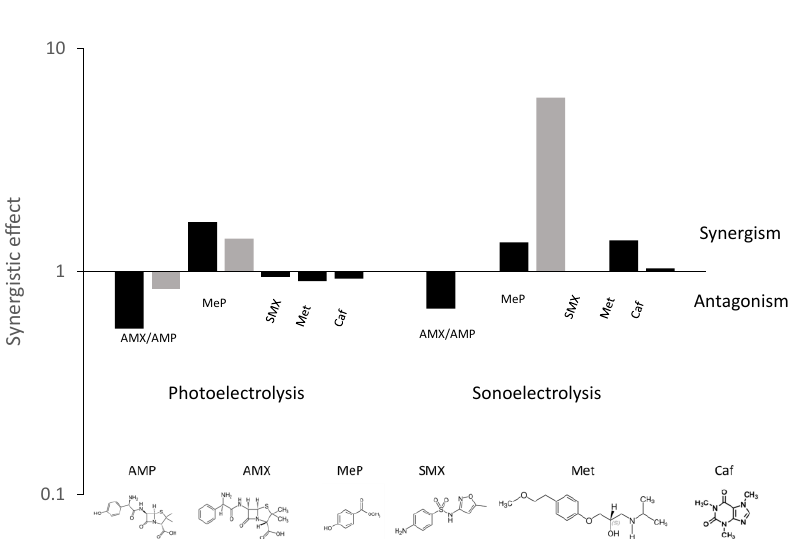
Figure 6. Synergistic/antagonistic effect of coupling irradiation techniques (UV light or ultrasound (US)) to the electrolysis of different organics: a mixture of amoxicillin and ampicillin (AMX/AMP), methylparaben (MeP), sulfomethoxazole (SMX), metroprolol (Met) and caffeine (Caf). Supporting electrolyte: ( (cid:4) ) sulphate and ( (cid:4) ) chlorine.